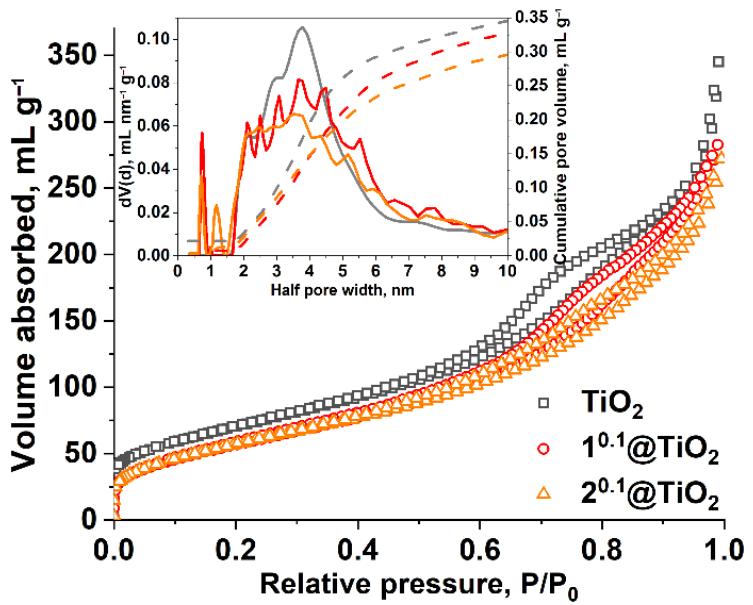
Figure 3. Nitrogen adsorption-desorption isotherms at 77 K. Inset shows pore sizes distribution according to DFT calculations. Color code: gray–TiO 2 , red–1 0.1 @TiO 2 , orange–2 0.1 @TiO 2 . The specific surface area was calculated by the conventional BET method and DFT approach. Pore volumes were calculated using the DFT method. All calculated parameters of the porous structure are given in Table 1. Table 1. The parameters of porous structure of samples under investigation.